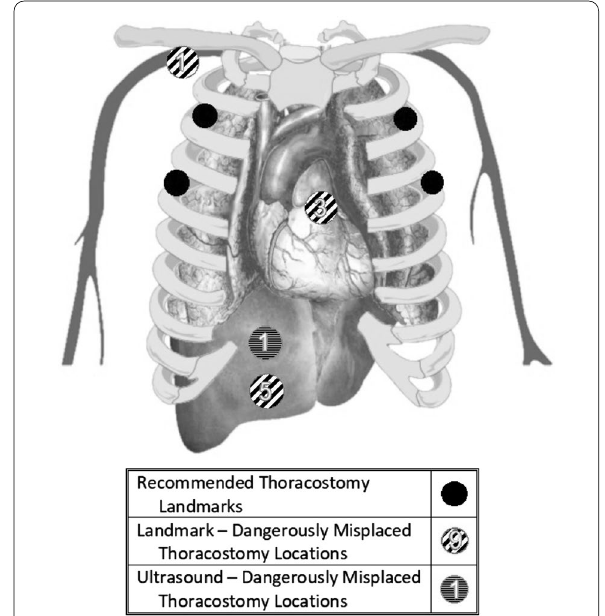
*Defined as in the correct interspace and midline location specified for the